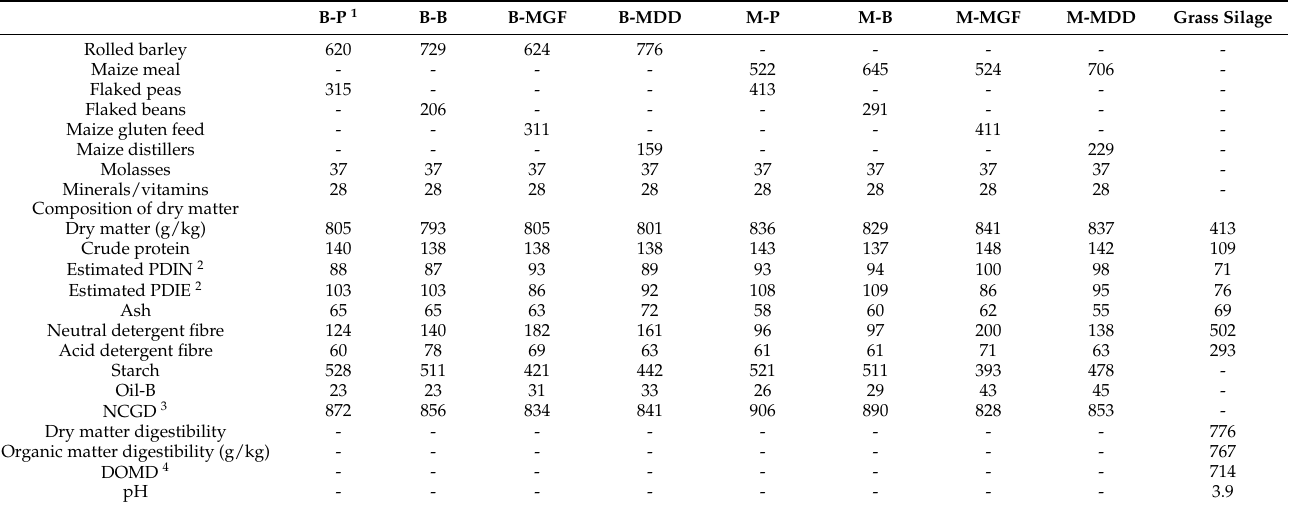
Table 2. Dry matter, chemical composition and in vitro digestibility (g/kg DM unless otherwise stated) of the perennial ryegrass-dominant grass silage and experimental concentrate rations used in Experiment